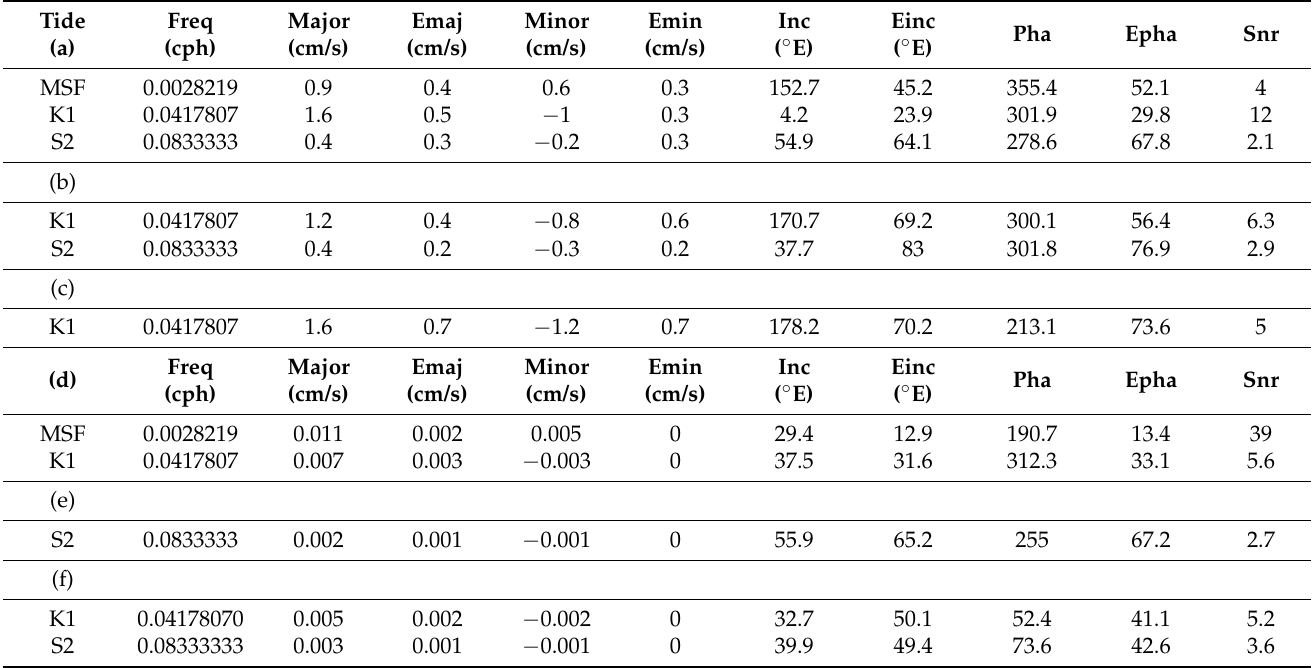
Table 13. Tidal ellipse parameters (major and minor axes, inclination and phase) together with 95%